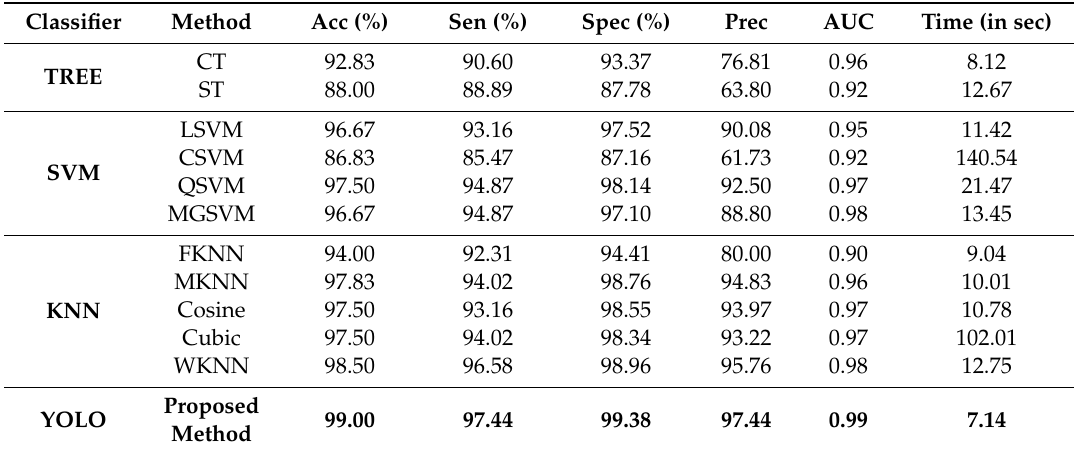
Table 13. Comparative study between proposed classifier and well-known classifiers on ISIB 2017 dataset.